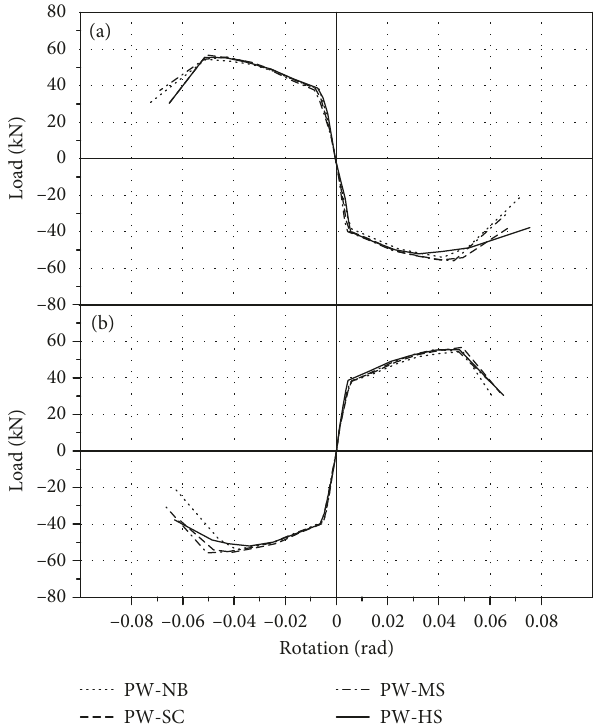
Figure 15: Skeleton curve of plastic hinge rotation for PW series. (a) Right plastic hinge rotation ( θ